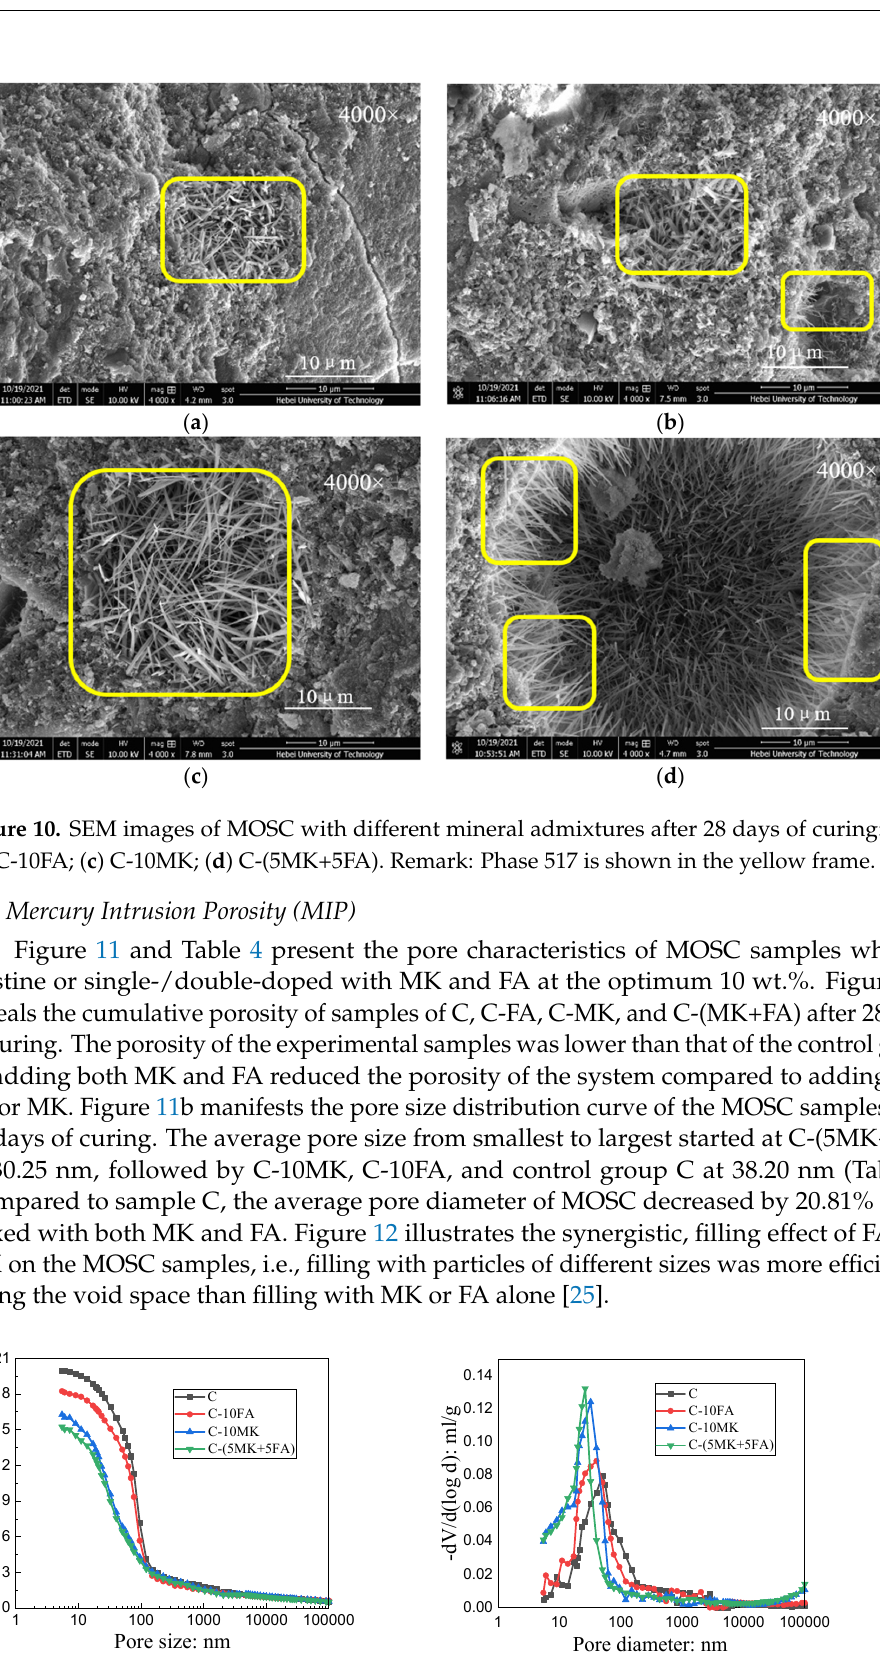
Figure 9. SEM images of MOSC with different mineral admixtures after 3 days o f curing: ( a ) C; ( b )